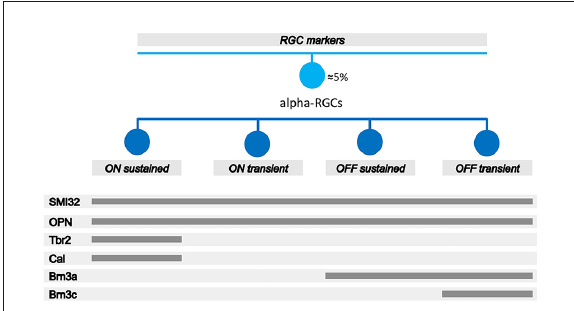
FIGURE1 Schematic diagram of the different antibodies to identify α RGCs and its subtypes by immunohistochemistry. SMI32 and OPN antibodies are pan-markers of α RGCs. The combination of SMI32 + or OPN + and Calbindin + or Tbr2 + antibodies are used to identify ONs- α RGCs; OPN + , Brn3a − , and Tbr2 − antibodies are used to identify ONt- α RGCs; SMI32 + or OPN + and Brn3a + and Brn3c − are used to identify OFFs- α RGCs; and SMI32 + or OPN + and Brn3a + and Brn3c + are used to identify OFFt- α RGCs. Figure adapted and modified from Krieger et al.